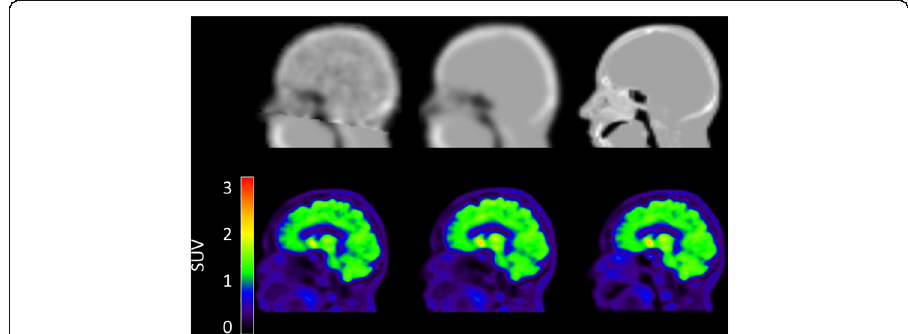
Fig. 1 First row, left to right — 68 Ge-, Atlas- and ZTE-attenuation correction (AC) maps; Second row — 11 C-PE2I PET images based on corresponding AC maps expressed as standardised uptake values